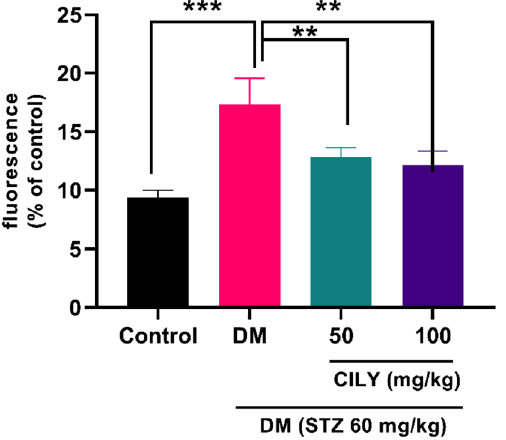
Figure 4. Silymarin attenuates ROS levels in the retina of diabetic rats. ROS levels were measured using 2 ′ -7 ′ -dichlorofluorescein-diacetate (DCFH-DA). Data are reported as mean ± SD. The differences between groups were compared using one-way ANOVA and Tukey’s post hoc test. Eight animals in each group were utilized for this experiment. ** and *** showing p < 0.01 and p < 0.001, respectively. DM: diabetes mellitus; SILY: